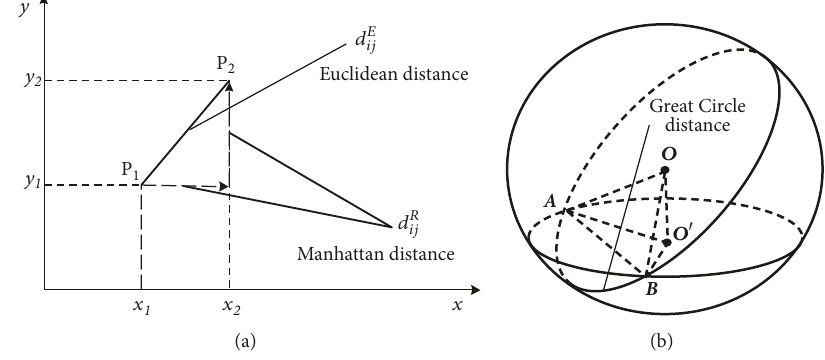
Figure 4: (a) Distance between two points; (b) great circle distance.